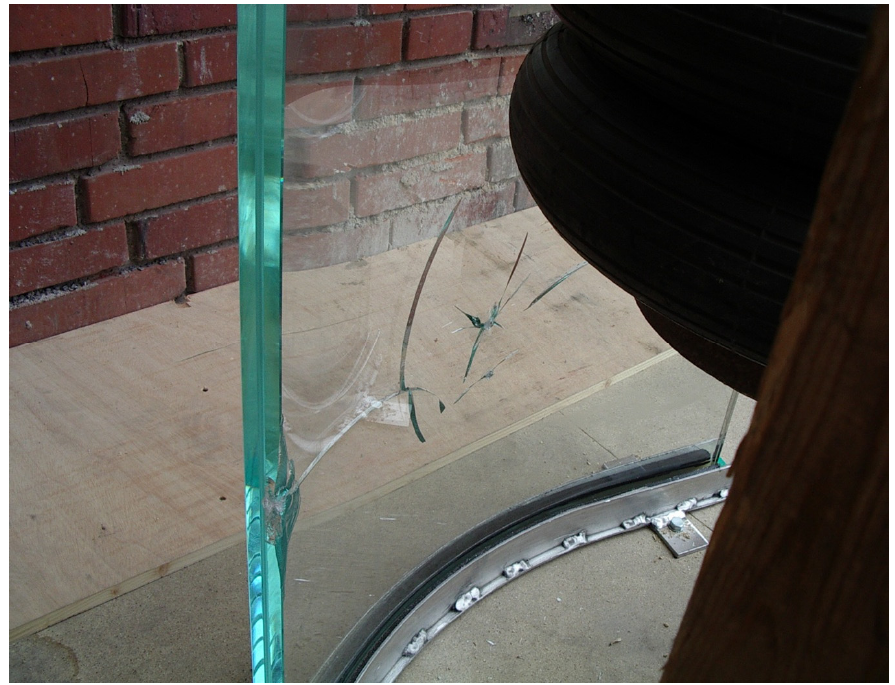
Figure 5: Hitting the inner pane at the edge before impact test and breakage effected by impact.